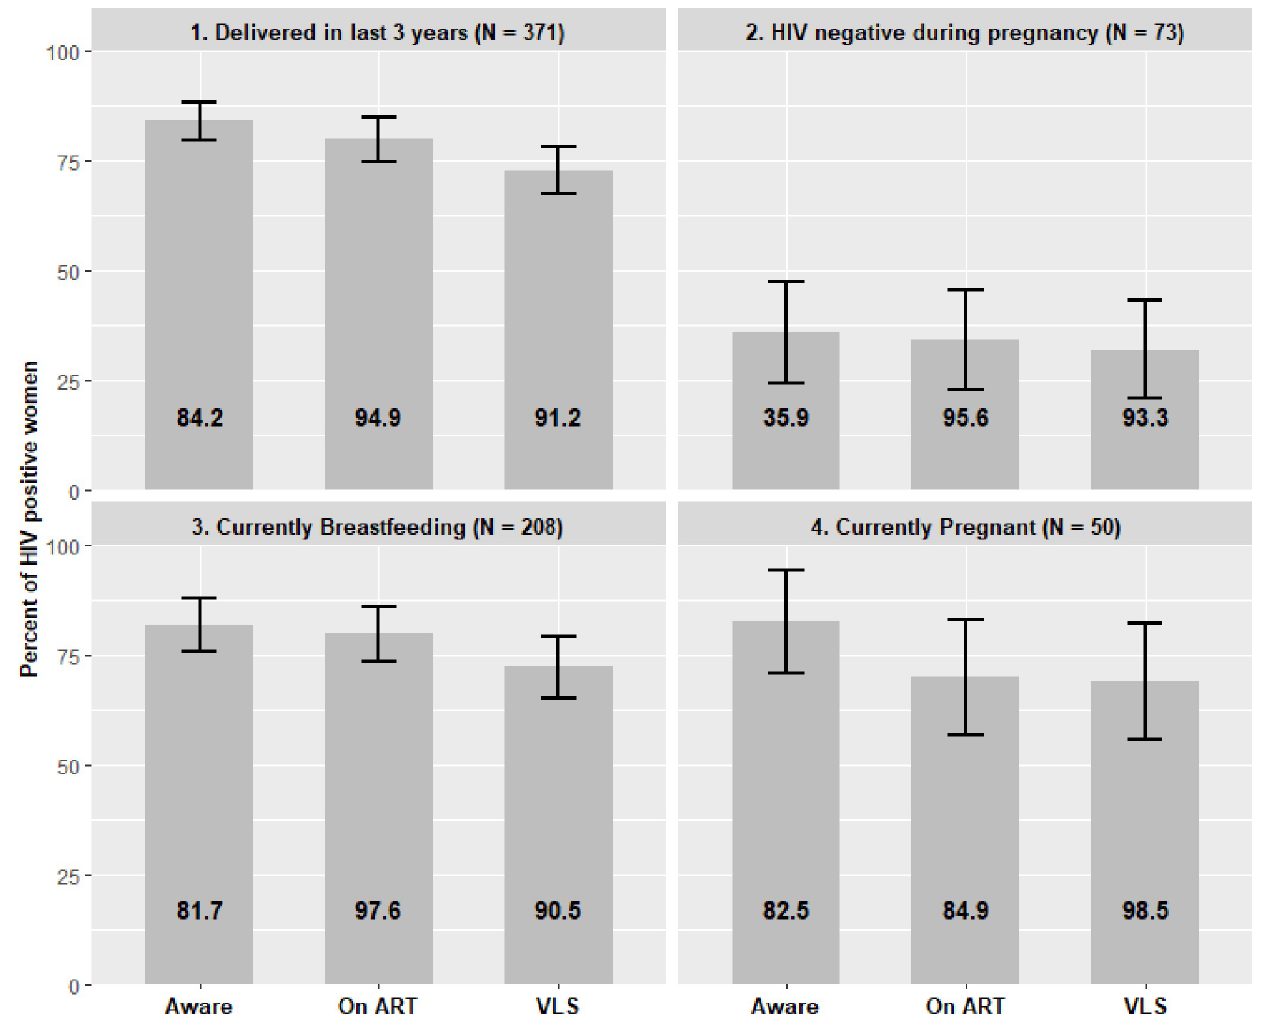
Fig 2. Joint United Nations Programme on HIV/AIDS 90-90-90 cascades among HIV-positive women aged 15–-64 years, Malawi Population-based HIV Impact Assessment (MPHIA) survey (2015–-2016). 1) Women who had a live birth in the 3 years before the survey. 2) Women who reported being HIV negative during the last pregnancy. 3) Women who were breastfeeding at the time of the survey. 4) Women who were pregnant at the time of the survey.